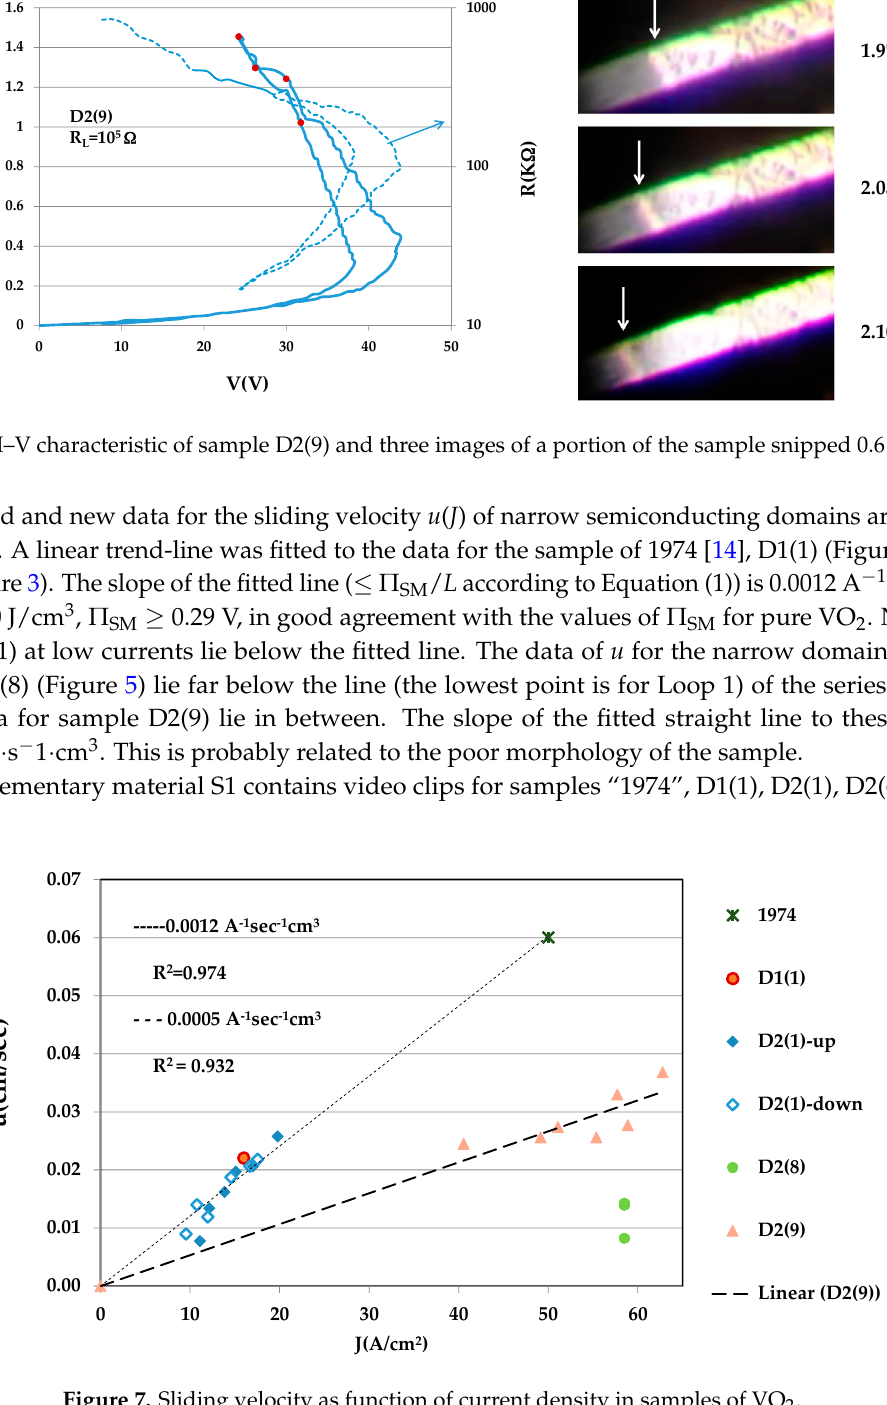
Figure 6. I–V characteristic of sample D2(9) and three images of a portion of the sample snipped 0.6 s apart. Sample D2(9) (dimensions 0.0057 × 0.0045 × 0.2 cm 3 ) with its rough matte surface was quite